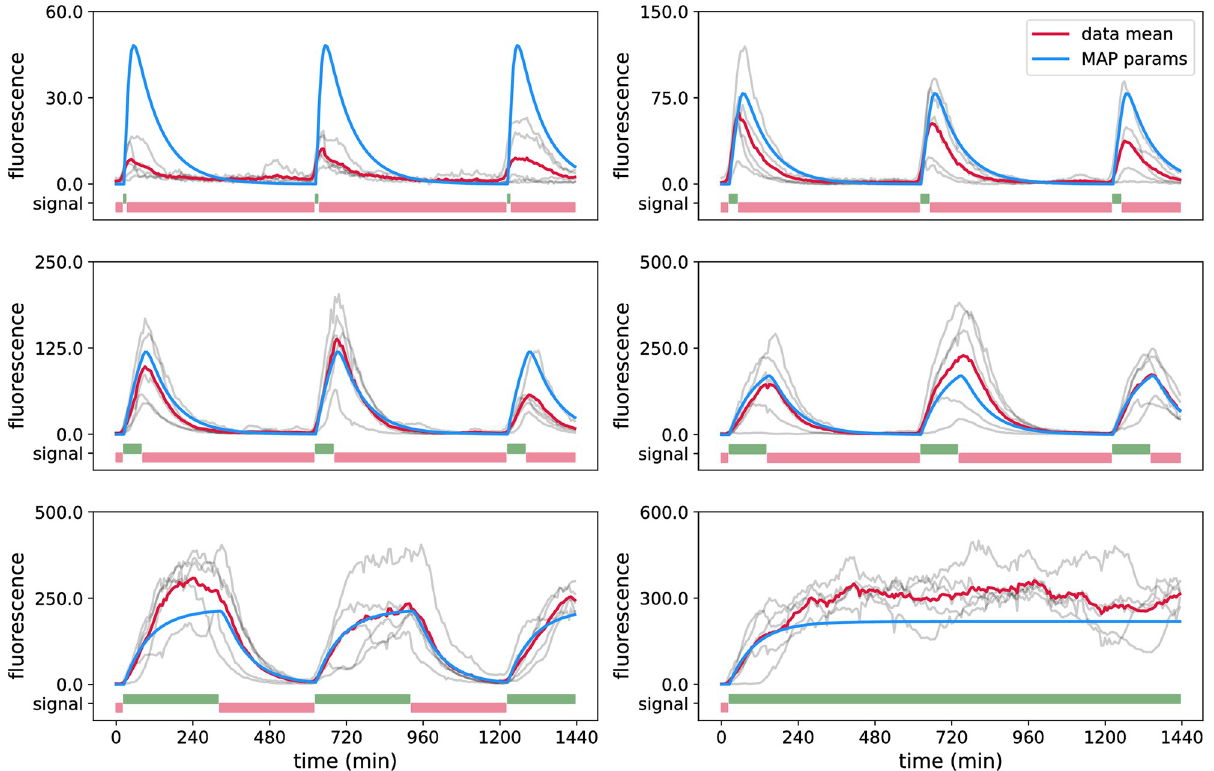
Fig 7. Experimental data for the CcaS/CcaR optogenetic system. The curated data set of 30 cells in total, 5 cells per panel, is shown in grey, where each trajectory shows the fluorescence of one cell over a period of 24 hours with the time between subsequent measurement points being 6 min. Each panel displays cells exposed to the same light inputs, u ( t ). Red and green light inputs are shown in red and green bars, respectively, at the bottom of each panel. Note that each light pattern starts with red light. The mean of the displayed cells is shown in red, and the blue lines are ideal means predicted by the model using MAP estimator obtained from this same data set (see Section C.5 and Table C, MAP (4), in S1 Text).